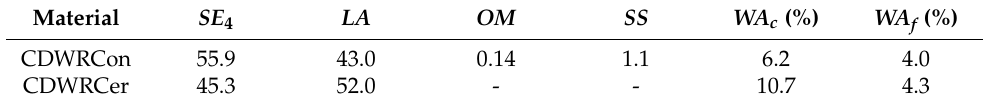
Table 3. Physical and chemical parameters for CDWRCon and